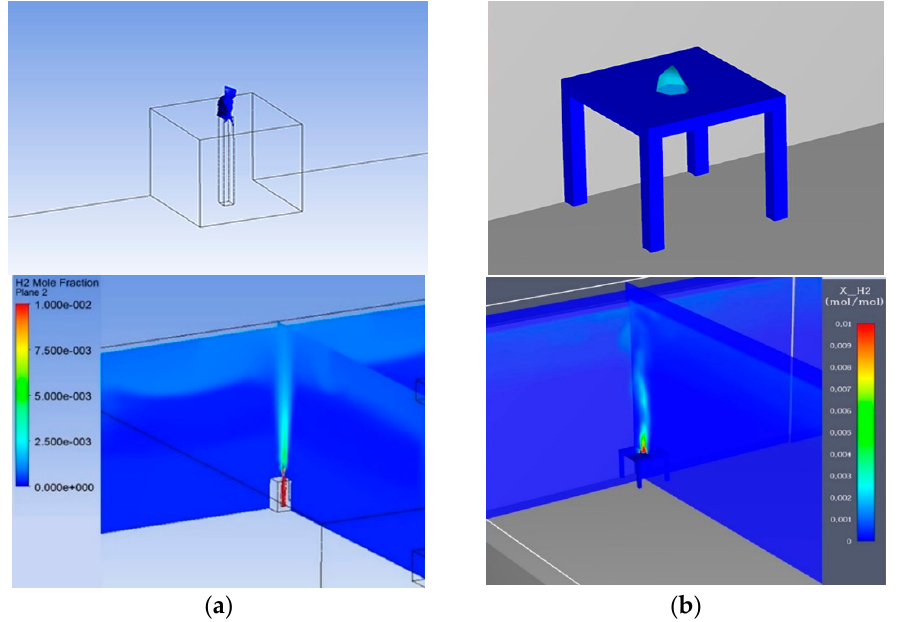
Figure 12. Iso-surface for hydrogen representing 25% concentration of LEL for ( a ) Ansys software and ( b ) FDS.